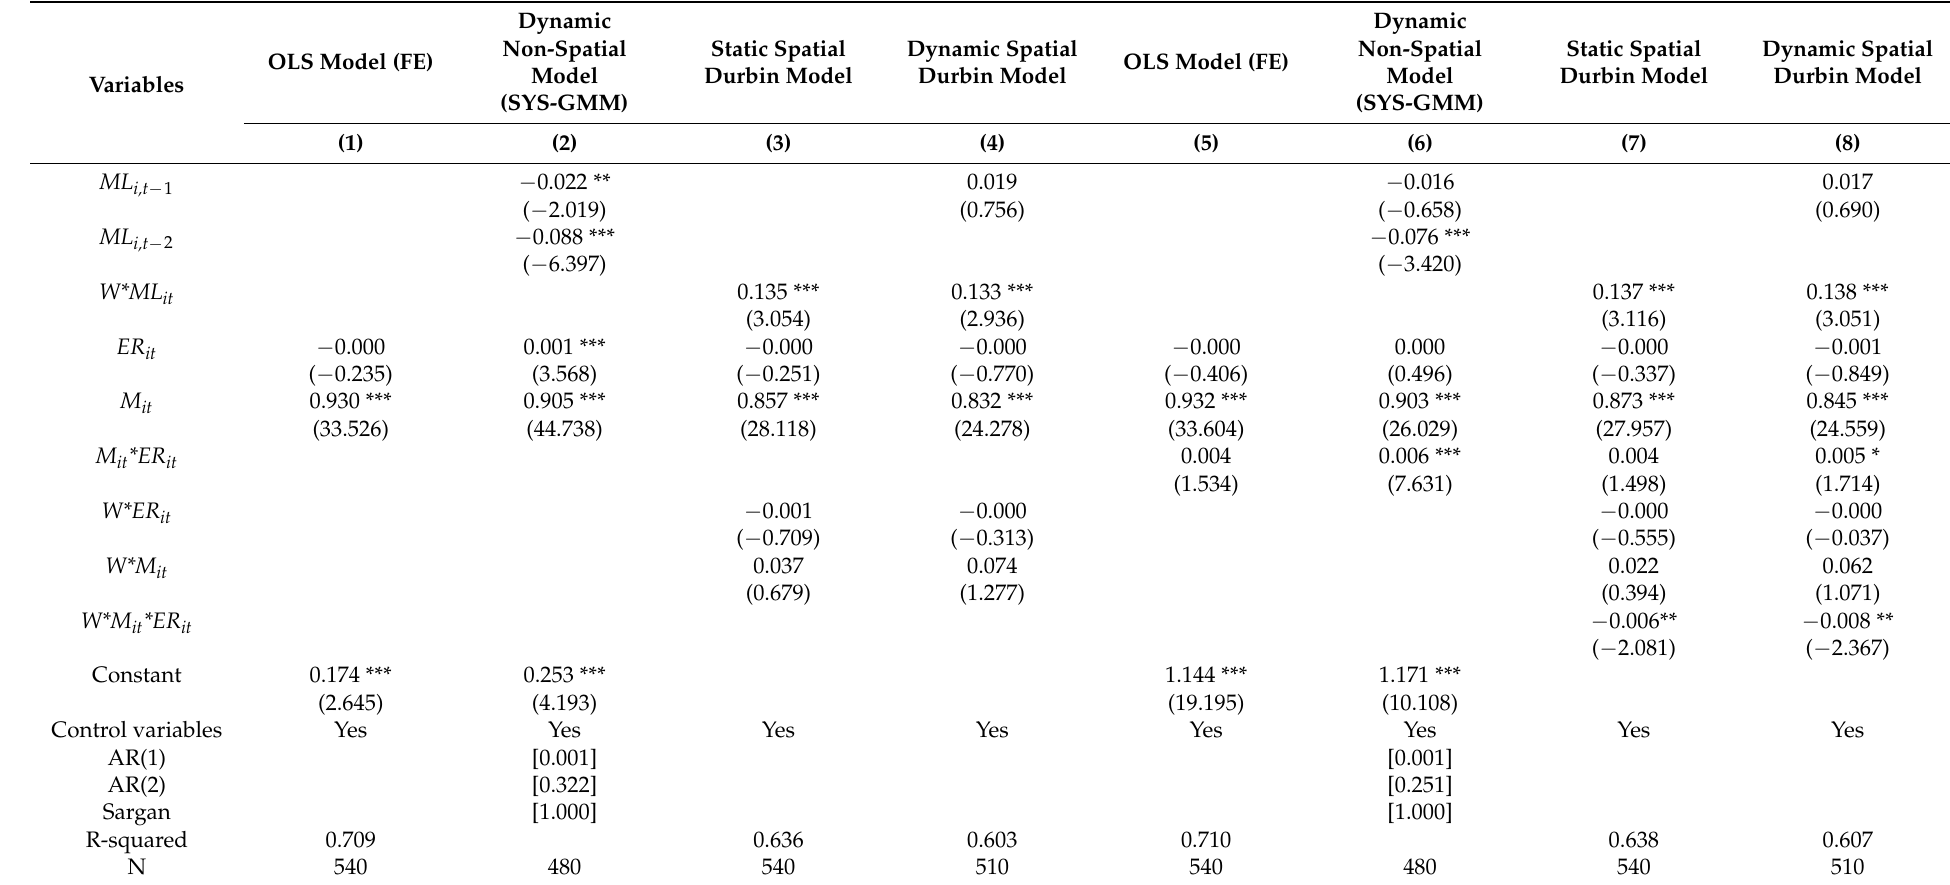
Table 4. The moderating results of technical change for the nexus between market-incentive environmental regulation and green